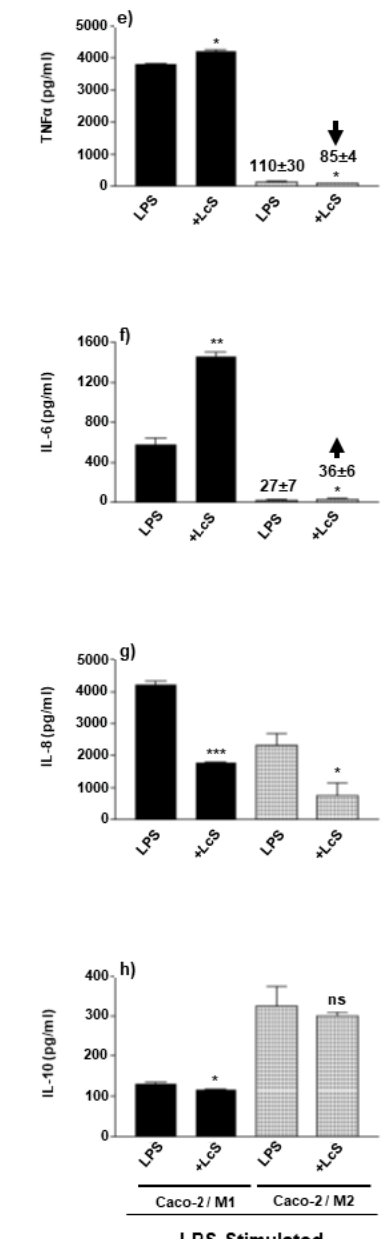
Figure 4. LcS differentially modulates M1 & M2 co-culture cytokines: dependency on LPS stim- ulation. Caco-2 epithelial cells were cultured to confluence (intact barrier) in transwell inserts and incubated in co- culture with M1 (bold) and M2 (hatched) Mφ subsets in the presence ( b , d , f , h ) or absence ( a , c , e , g ) of apically applied LPS stimulation (100 ng/mL) in the presence or absence of apically applied LcS. The pro-inflammatory cytokines, TNF α ( a , b ), IL-6 ( c , d ), IL-8 ( e , f ) and anti-inflammatory cytokine, IL-10 ( g , h ) were measured by sandwich ELISA and presented as protein production of the same secreted cytokines as the mean ± SD in pg/mL. Data displayed is a representative experiment with triplicate samples for n = 3 replicate experiments. Significant effects of LcS are compared to either the unstimulated control or LPS-stimulated control and are indicated as * p < 0.05, ** p < 0.01, *** p < 0.001 and ns, not significant and small scale changes ( a , e , f ) are indicated with arrow bars indi- cating augmentation or suppression and accompanied with an indication of cytokine concentration